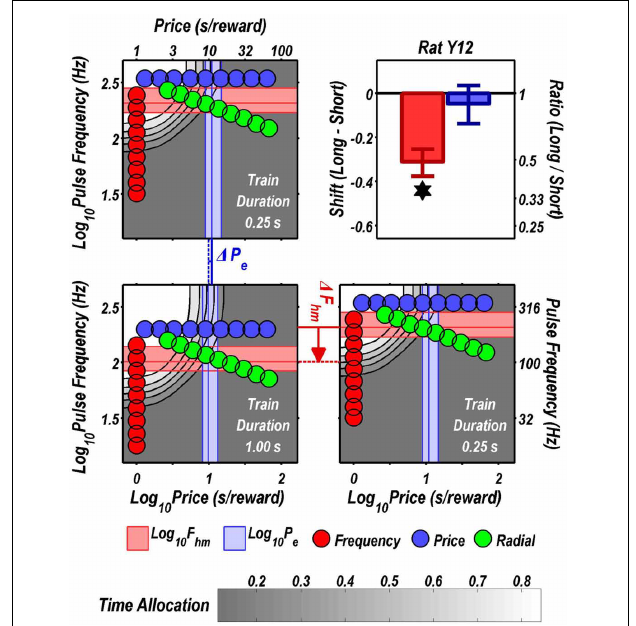
FIGURE 5 | Shifts of the reward mountain. The contour graph for the long-duration (1s) train is shown in the lower left. For comparison the contour graph for the short-duration (0.25s) train is shown twice, in the upper left and lower right. The P e parameter determines the location along the price axis, whereas the F hm parameter determines the location of the mountain along the pulse-frequency axis. The vertical blue line represents the estimate of P e , and the surrounding band represents the corresponding 95% confidence interval. The horizontal red line represents the estimate of F hm , and the surrounding band represents the corresponding 95% confidence interval. The bar graph shows the mean shifts in the location parameters due to the increase in train duration from 0.25 to 1s along with the associated 95% confidence intervals. ∗ Indicates that the 95% confidence interval does not include